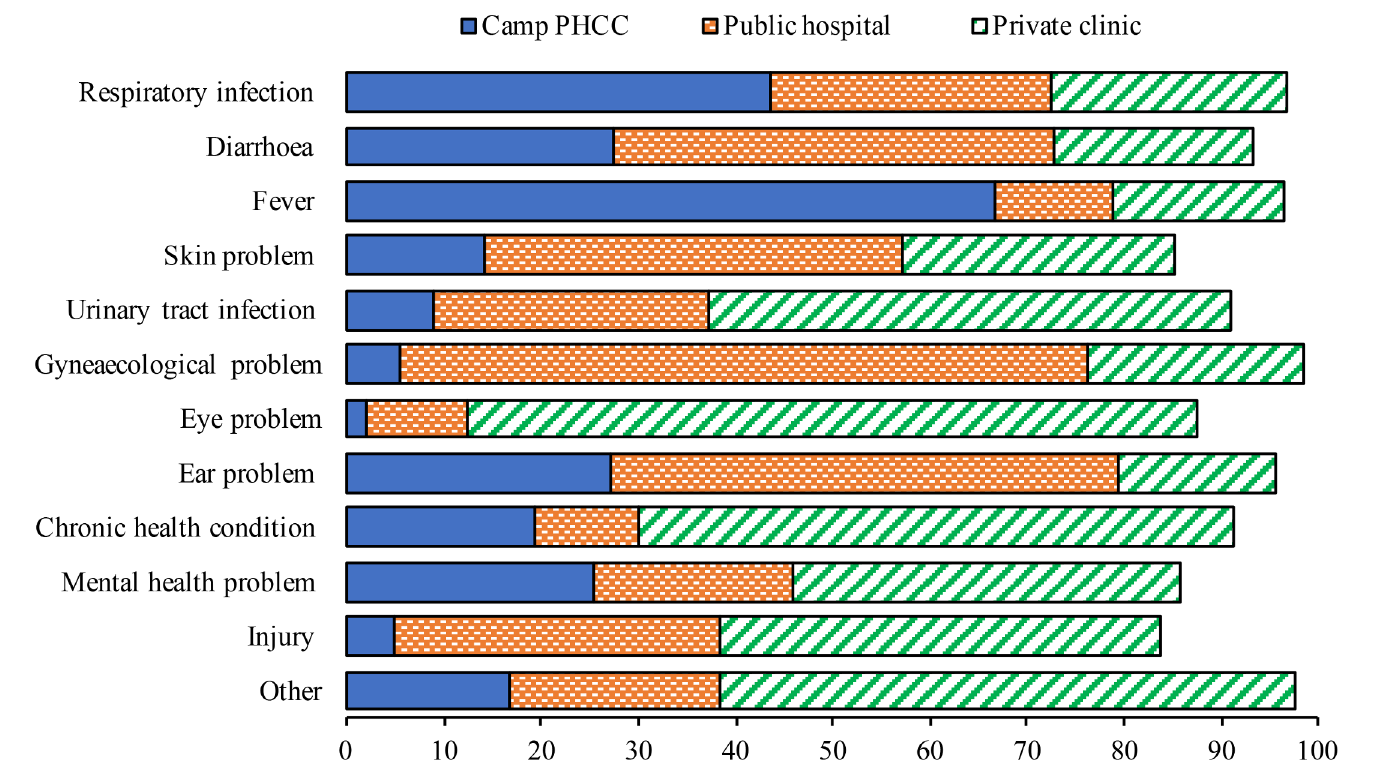
Fig 1. Care seeking in the two weeks preceding the survey.